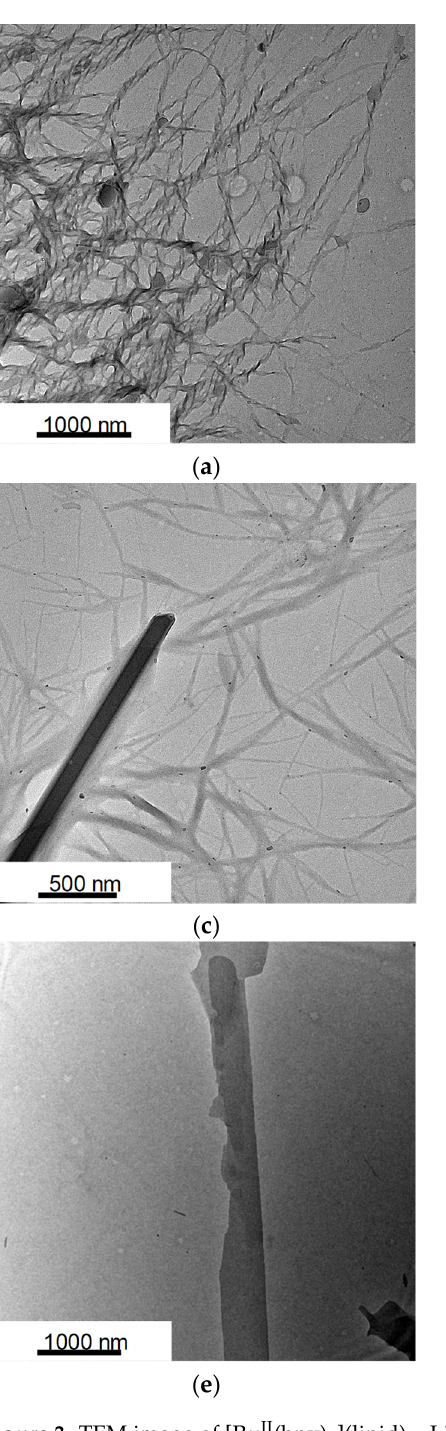
Figure 3. TEM image of [Ru II (bpy) 3 ](lipid) 2 . Lipid = 1 ( a ), 2 ( b ), 3 ( c ), 4 ( d ), 5 ( e ), and 6 ( f ) samples